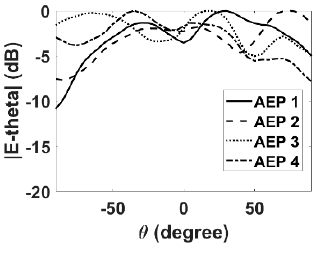
Figure 8. Measured active element patterns (E plane).